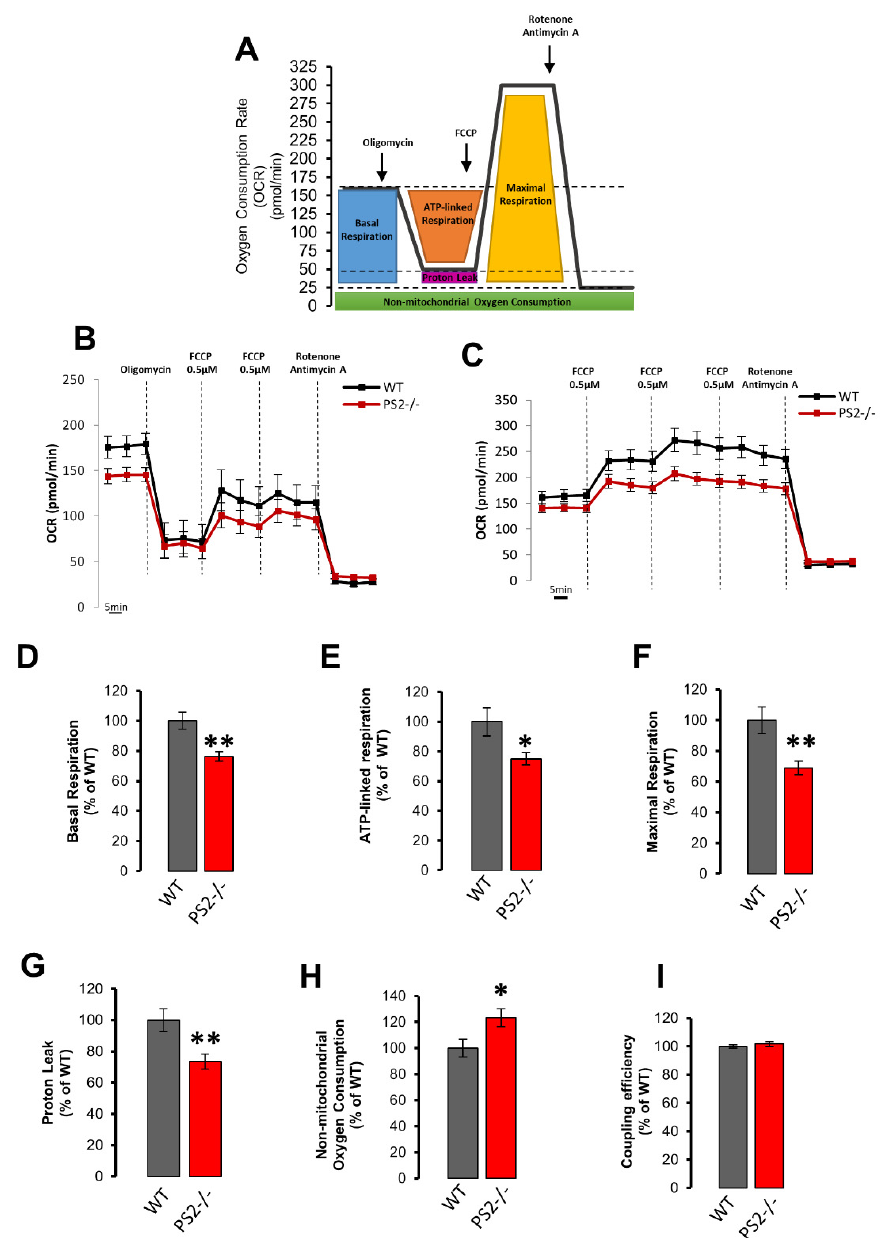
Figure 5. The lack of PS2 slightly affects mitochondrial respiration. ( A ) Oxygen consumption rate (OCR) experimental protocol. ( B – C ) OCR mean traces in WT (black) and PS2–/– (red) primary cor- tical neurons. Oligomycin (Oligo, 1 µM), FCCP (0.5 µM), and antimycin A (0.1 µM) plus rotenone (1 µM) were added as indicated. Data are plotted as mean pmol/min ± SEM ( n > 45 wells from at least 6 independent cultures). ( D – I ) Quantification of OCR measurements in panels B and C. The bar graph shows the mean ± SEM as a percentage of WT, obtained in WT (gray) or PS2–/– (red) cortical neurons of: ( D ) the basal OCR (calculated as differences between initial OCR and OCR after antimycin A/rotenone addition), ** p < 0.01; ( E ) the mean ATP-linked OCR (calculated as differences between initial OCR and OCR after oligomycin addition), * p < 0.05; ( F ) the mean of the maximal respiratory capacity (calculated as difference between OCR after FCCP addition and the OCR after antimycin A/rotenone addition) , ** p < 0.01; ( G ) the mean proton leak (calculated as differences between the oligomycin-sensitive OCR and OCR after antimycin A/rotenone addition) , ** p < 0.01; ( H ) the mean non-mitochondrial OCR (OCR remaining after addition of all drugs), * p < 0.05; ( I ) the mean coupling efficiency (calculated as ratio between ATP-linked OCR and basal OCR).